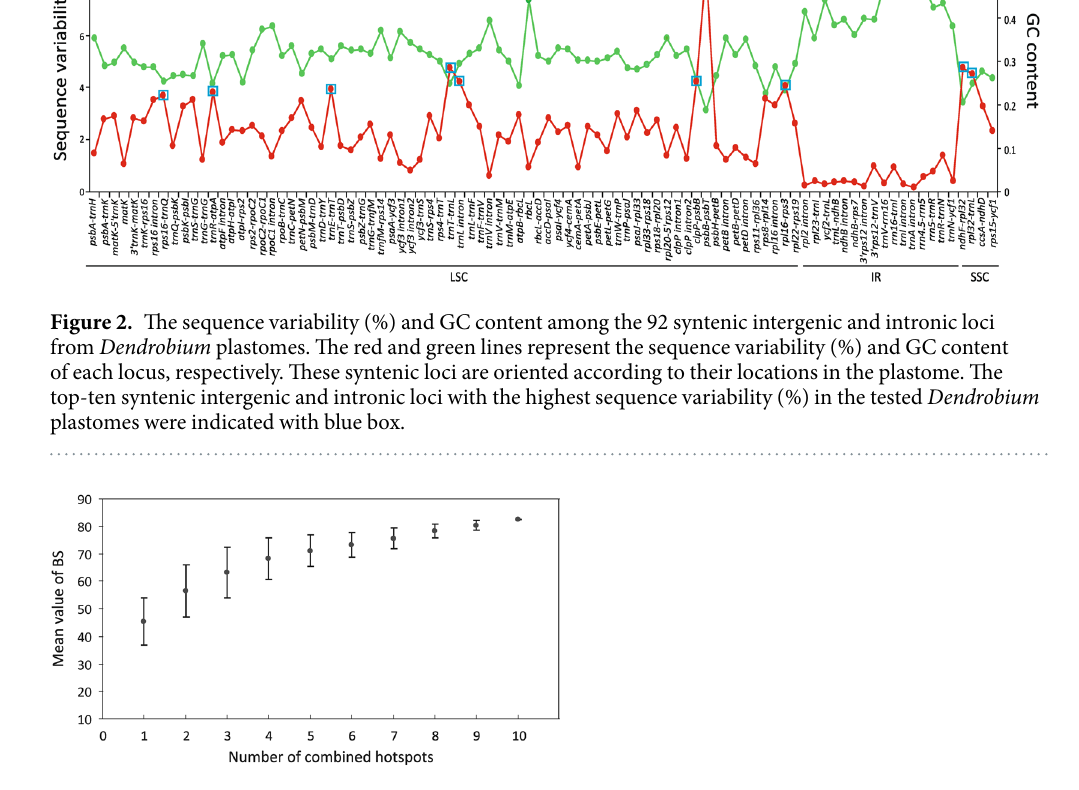
Figure 3. Relation between the number of combined hotspots and the mean value of bootstrap (BS). The mean ( ± SD) BS values were calculated based on different numbers of combined hotspots. Regression analysis: R 2 = 0.904, y = 3.64x + 49.38. The plateau of the mean BS value reached 71% when five hotspots were combined.